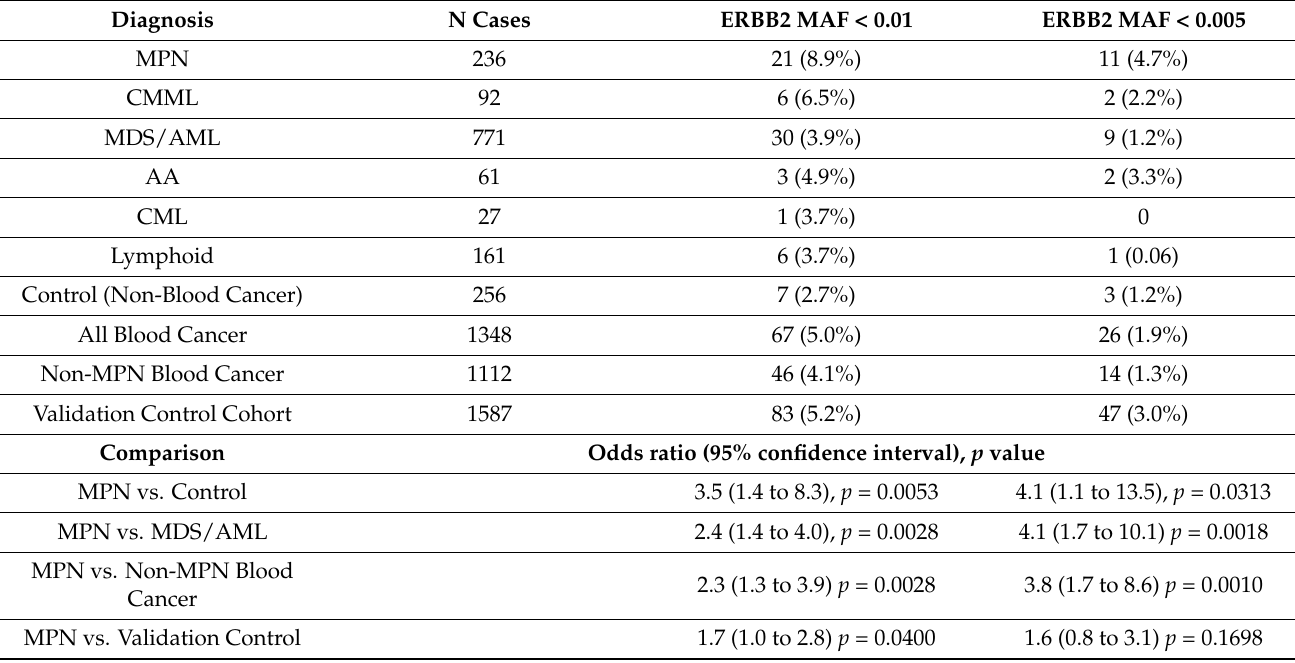
Table 1. Evaluation of germline ERBB2 variants identified and cancer cases and